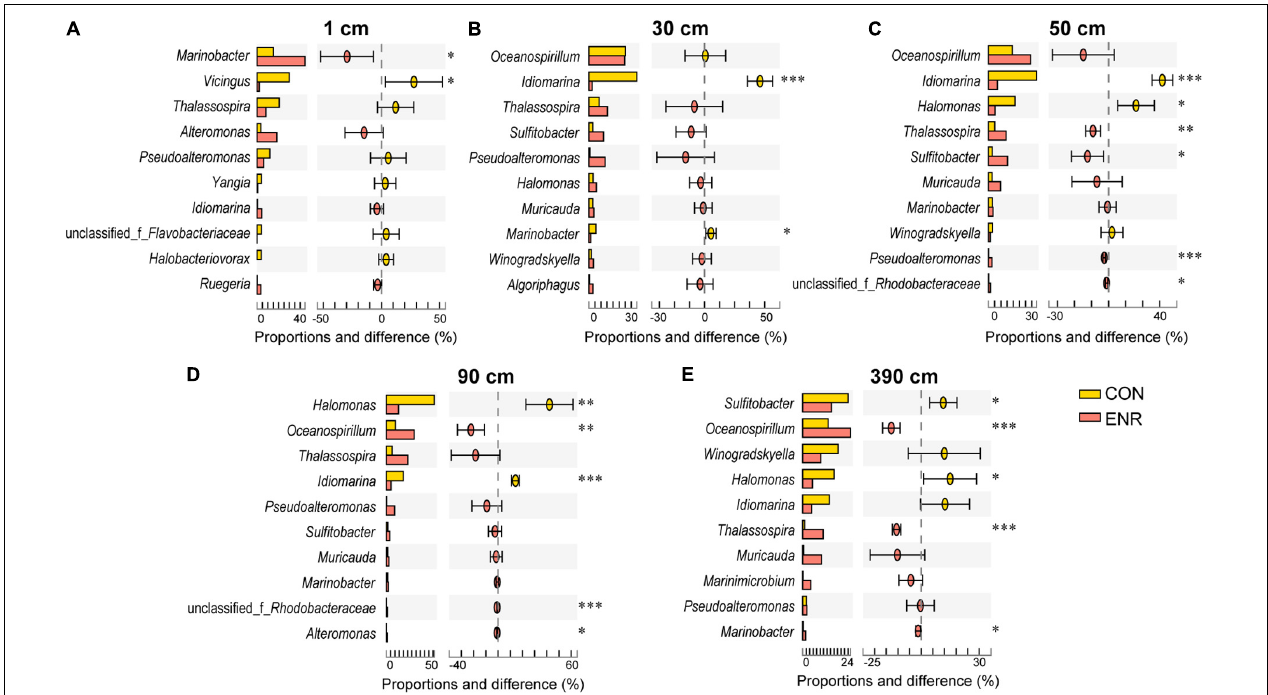
FIGURE 6 | Genus-level differences between the control and DMSP-enriched samples. The proportion represents the relative abundance of each genera revealed by 16S rRNA gene amplicon sequencing. CON, the control group in normal MBM; ENR, the DMSP-enriched groups in modified MBM. * p < 0.01 in Student’s t -test; ** p < 0.001 in Student t -test; *** p < 0.0001 in Student’s t